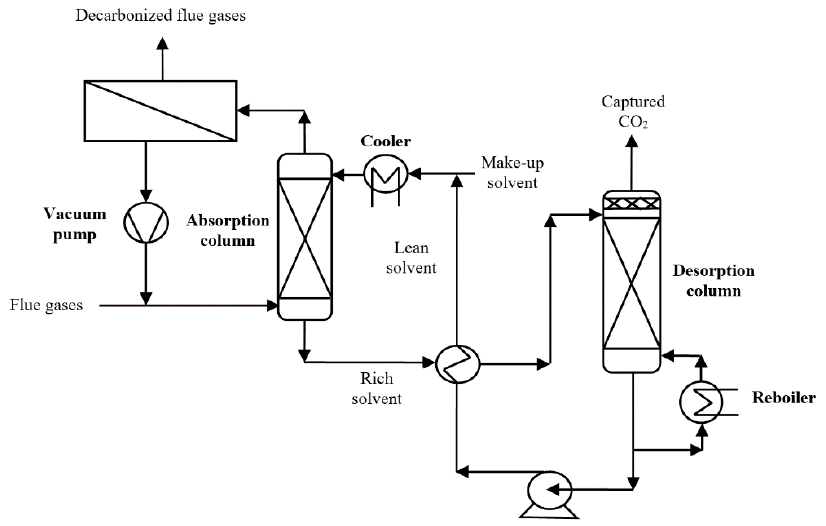
Figure 5. Layout of hybrid system with membrane unit at the top of absorption column.